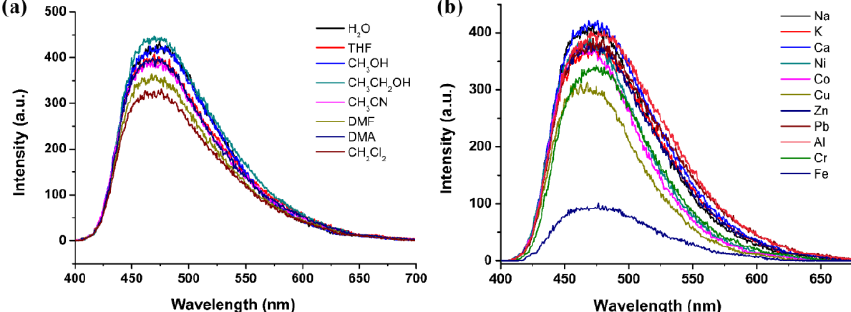
Figure 3. The FL of the powdered Sr 2 (tcbpe) dispersed in different solvents ( a ) and 0. 5 × 10 −2 M aqueous solution containing different metal ions ( b ).